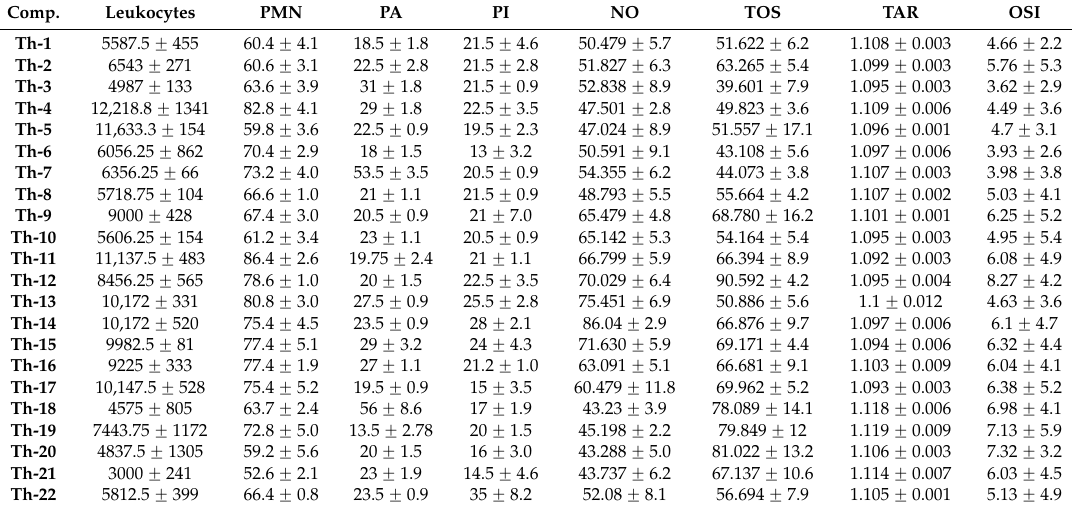
Table 2. Effect of thiazolyl-carbonyl-thiosemicarbazides and thiazolyl-azoles on the determined biological parameters for anti-inflammatory and antioxidant activities.